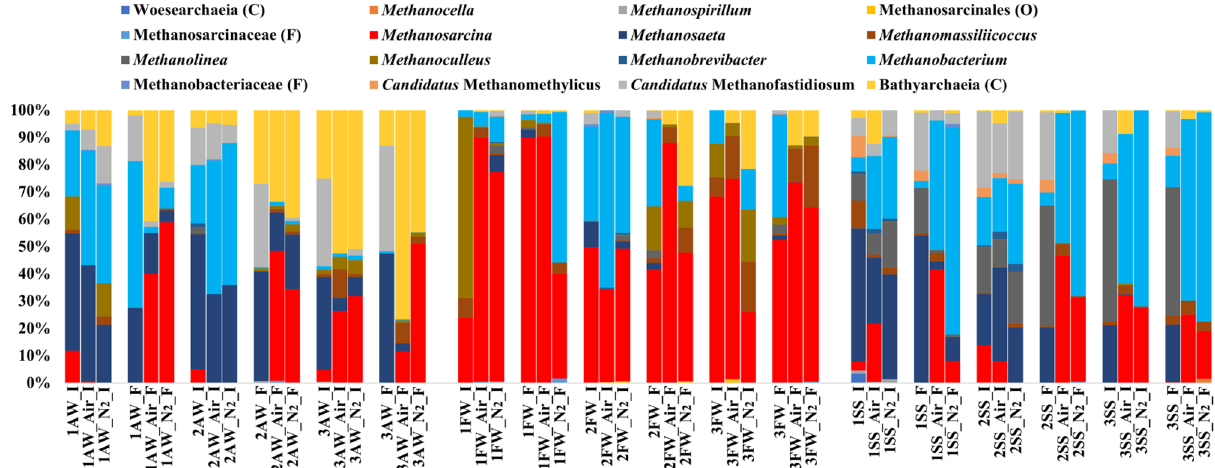
Figure 1. Relative abundance of the archaeal community at the genus level of three types of sludge ( AW agricultural waste, FW food waste, and SS sewage sludge) separated after the drying-rewetting (sample name ends with “I”) and incubation events (sample name ends with “F”). From left to right of each figure, blocks corresponding to the first, second, and third drying-rewetting and incubation events (sample names start with 1, 2, and 3, respectively). Where the genus name could not be assigned to the sequences, the closest classified taxonomic level is depicted: class (C), order (O), and family